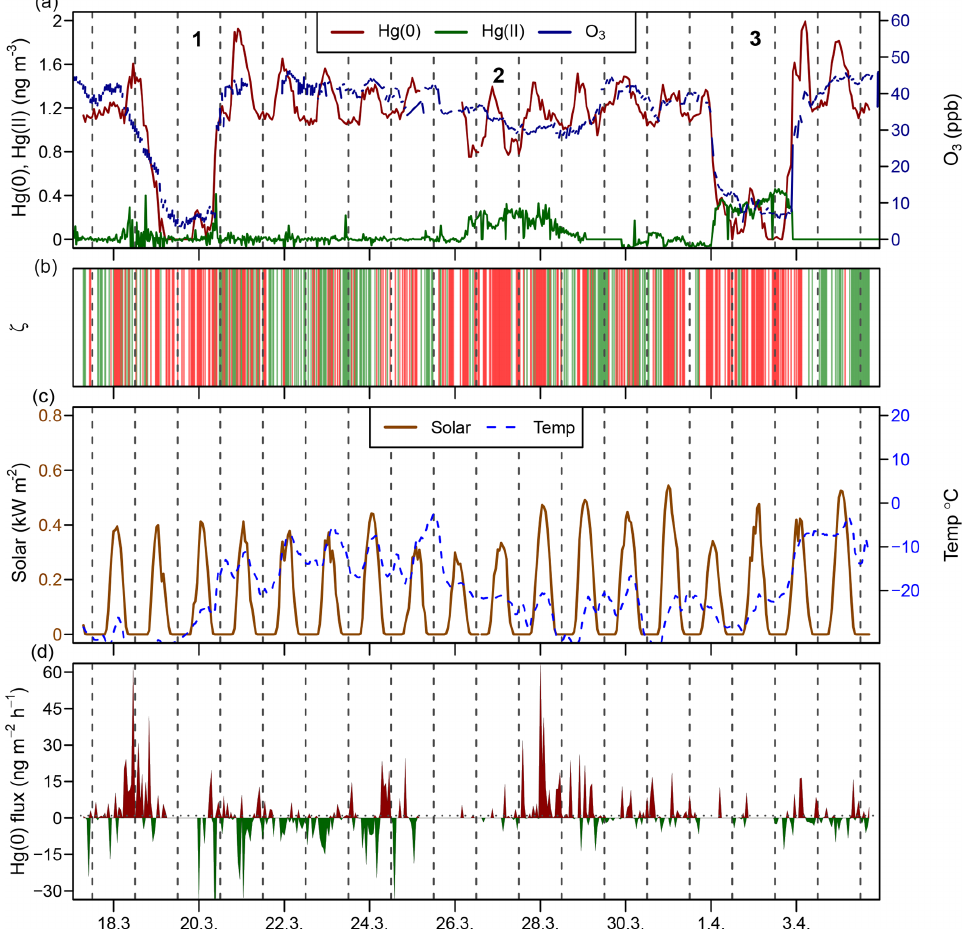
Figure 3. Time series during the springtime AMDE period (18 March–4 April 2016) for (a) the atmospheric Hg(0) concentration (red), the atmospheric Hg(II) concentration (green), and the O 3 mixing ratio (blue); (b) planetary boundary layer stability ( ζ ), where the shaded areas in green represent stable conditions ( ζ > 0 . 1) and shaded areas in red represent turbulent conditions ( ζ < − 0 . 1); (c) solar radiation and air temperature; and (d) Hg(0) flux, where Hg(0) deposition is shown using green and Hg(0) re-emission is shown using red. Midnight is indicated by dashed lines. Strong AMDEs when Hg(0) concentrations dropped (1, 3) or Hg(II) concentrations increased (2) are marked using